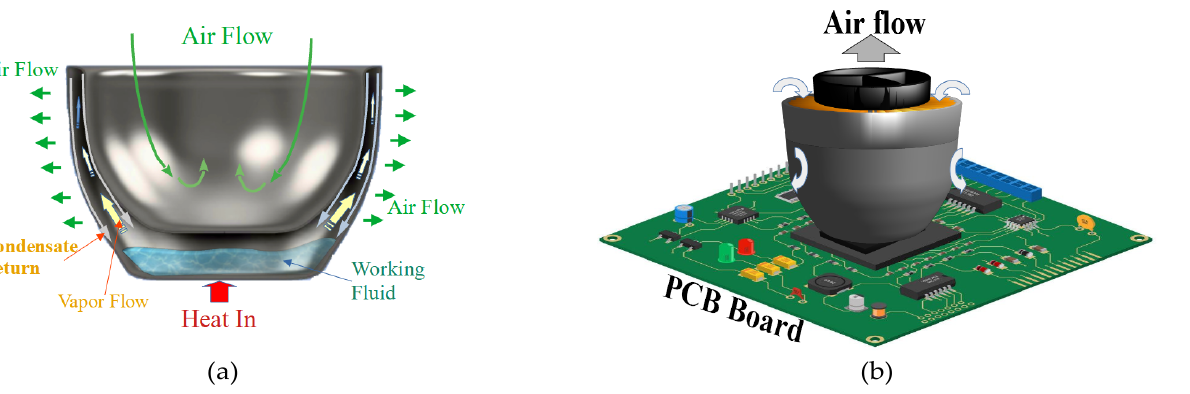
Figure 1. Schematics of the operation of a conventional vapor chamber.